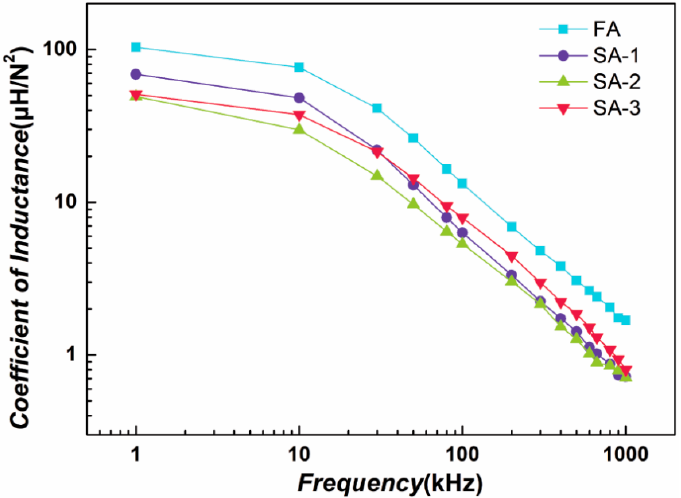
ffi cient of inductance (e ff ective permeability) in